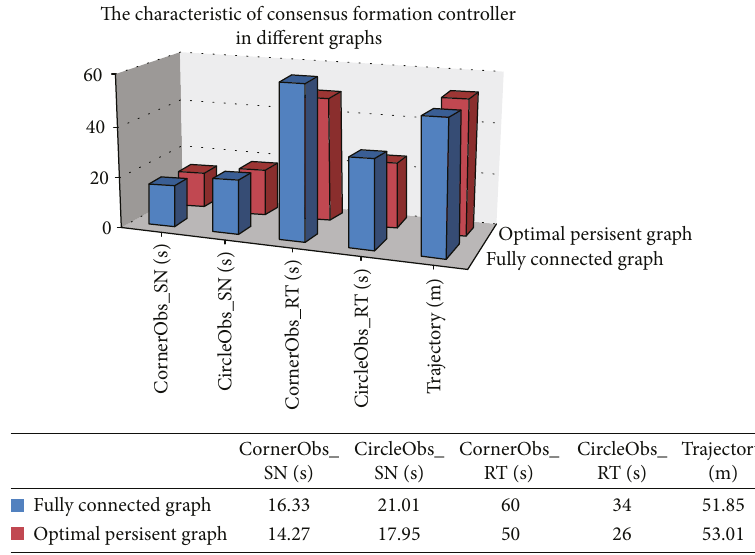
Figure 25: The characteristics of consensus formation controller in di ff erent graphs. SN denotes the smoothness of the trajectories around the corner or circle obstacle and RT denotes runtime time around the corner or circle